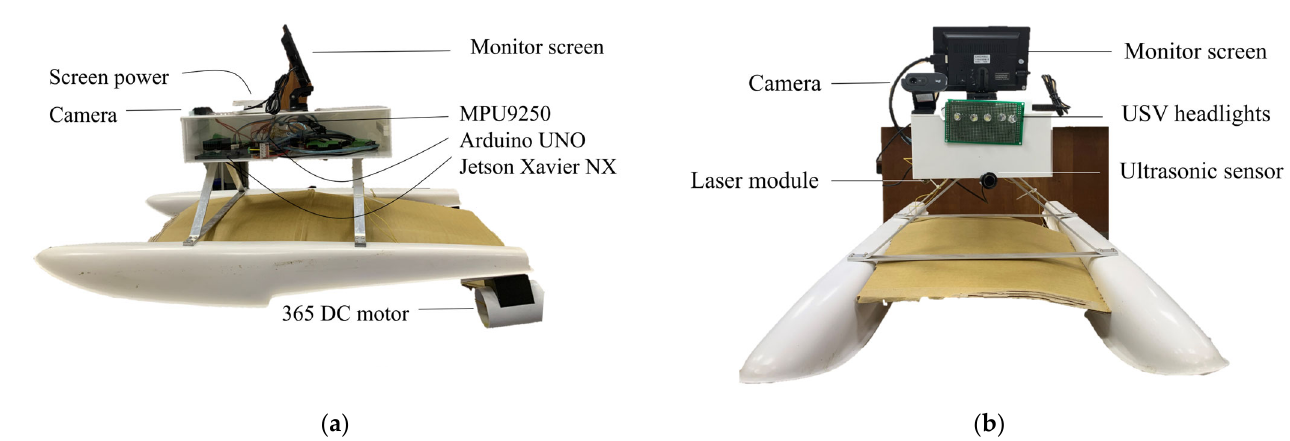
Figure 11. The USV as: ( a ) side view; ( b ) front